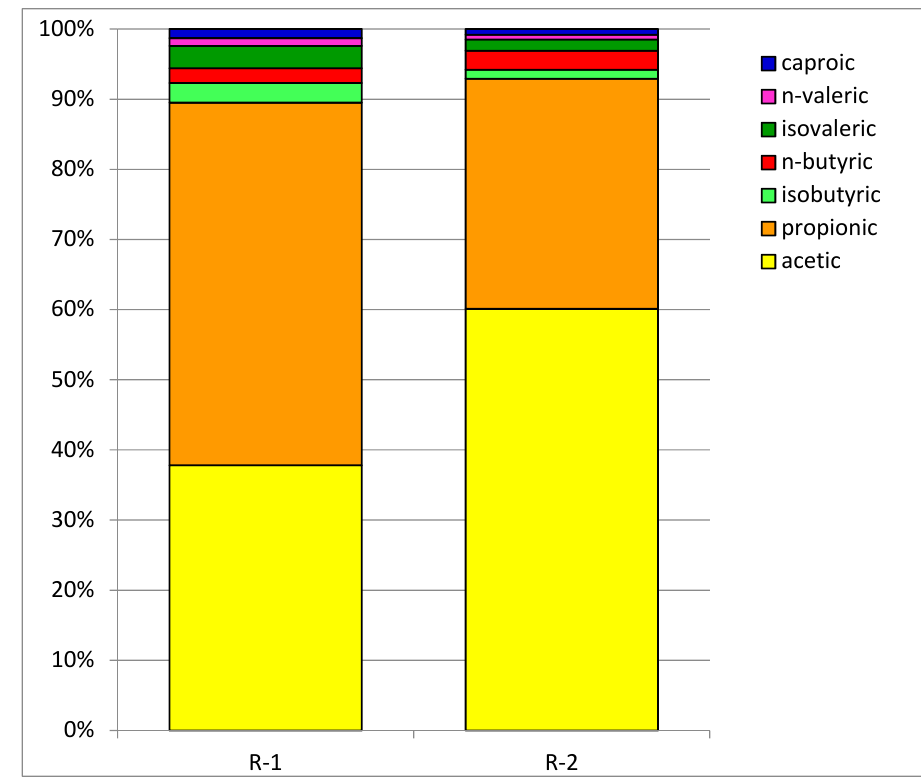
Figure 7. Percentages of individual volatile fatty acids in total VFA of digestates.